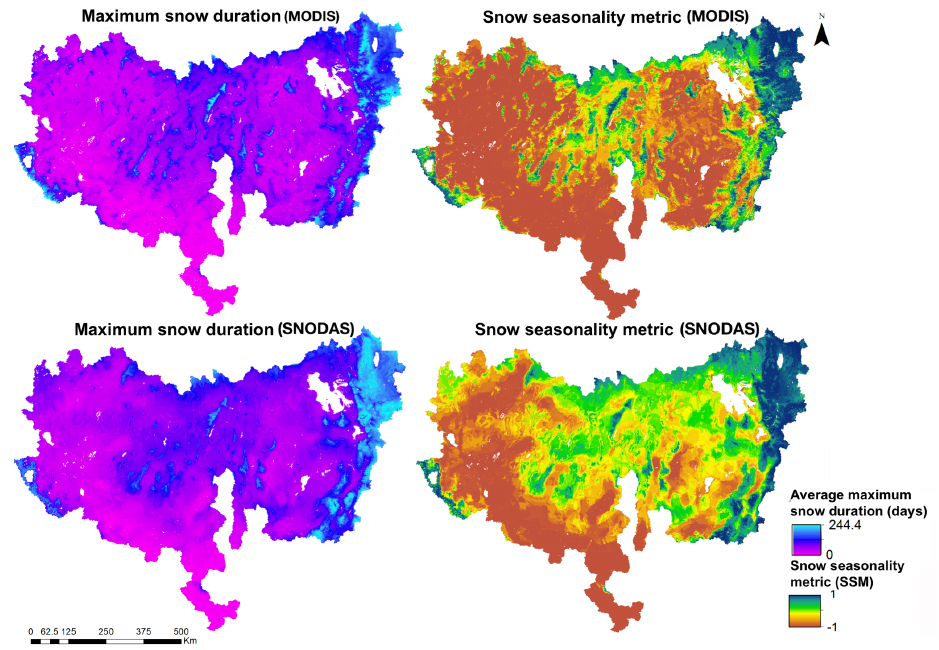
Figure 5. The average maximum consecutive snow duration (maximum snow duration) and snow seasonality metric (SSM) for the Great Basin measured using MODIS and Snow Data Assimilation System (SNODAS) data in the Great Basin, USA, for water years